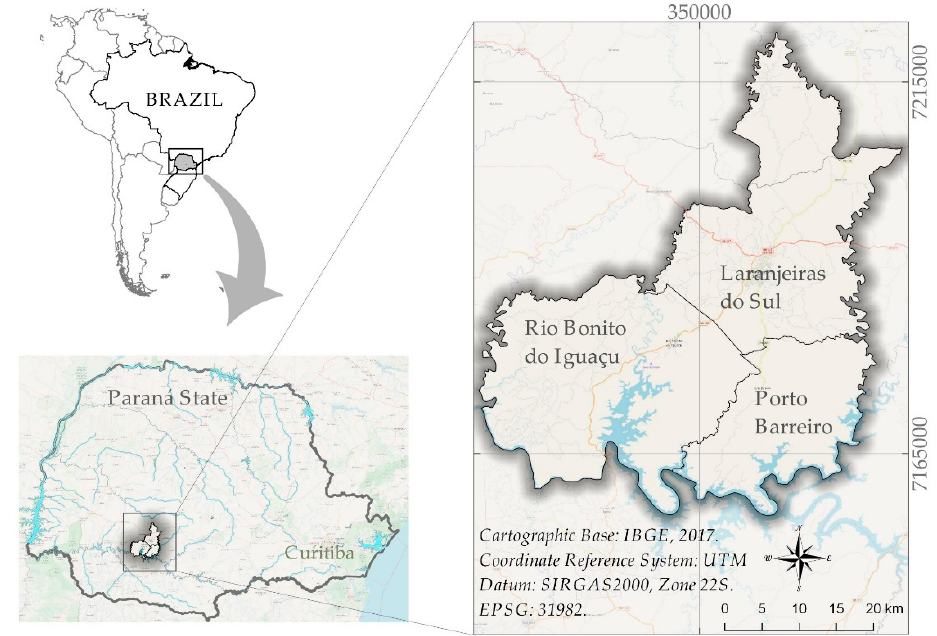
Figure 1. Geographic location of the study area in the Brazilian state of Paraná as per the QGIS software, version 3.6.3. It is a Cfb temperate climate according to the Köppen classification system.